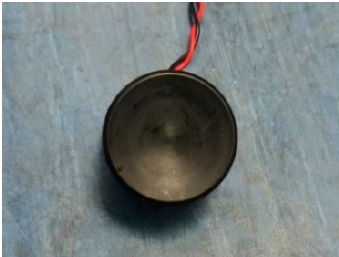
The actual photos of the concave ultrasonic transducer used in the experiment are shown in Figure 3. The transducer was used in the borehole LWD ultrasonic imaging tool. It had a radius of 15 mm, a concave curvature radius of 60 mm, a height of 20 mm and a dominant frequency of 250 kHz.